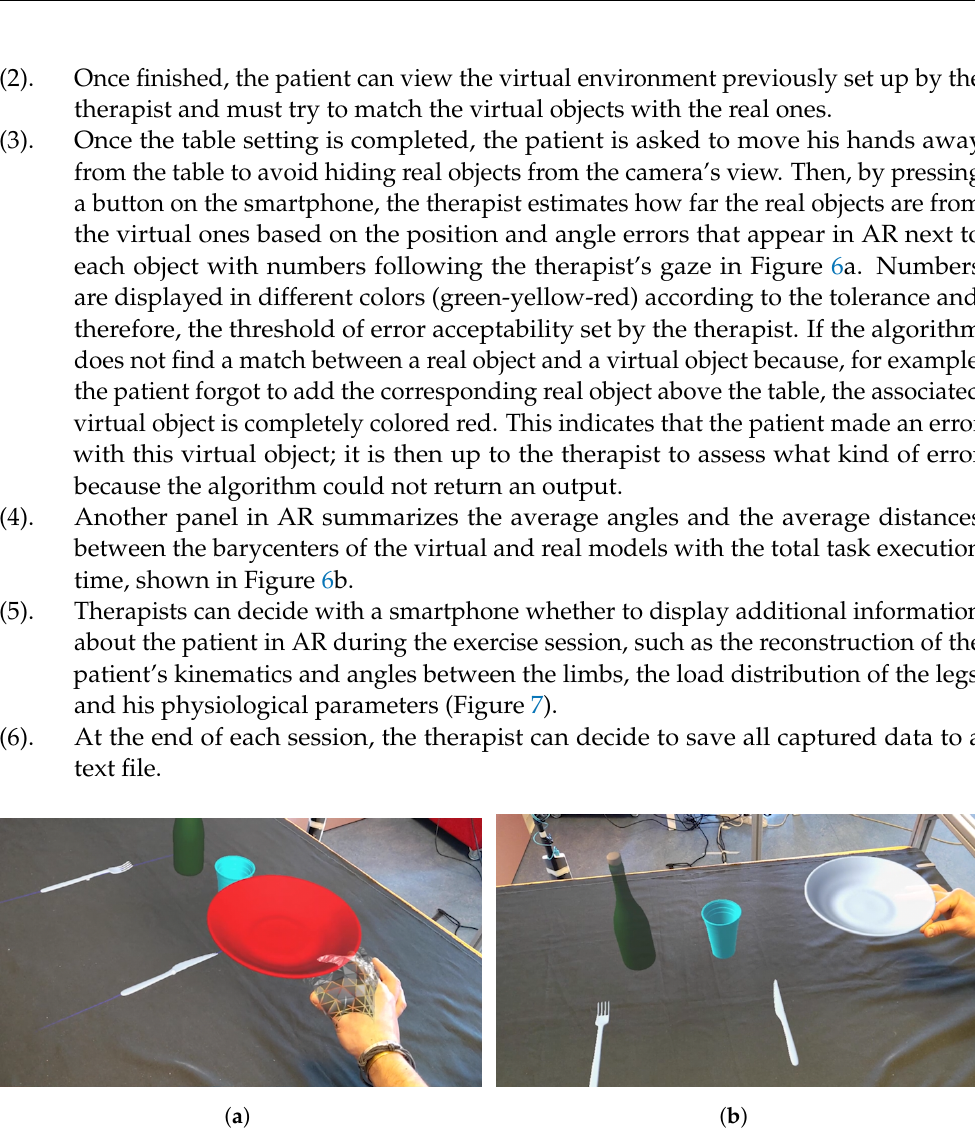
Figure 5. Example of a shared AR environment from the field of view of the ( a ) therapist’s HoloLens and ( b ) patient’s HoloLens.